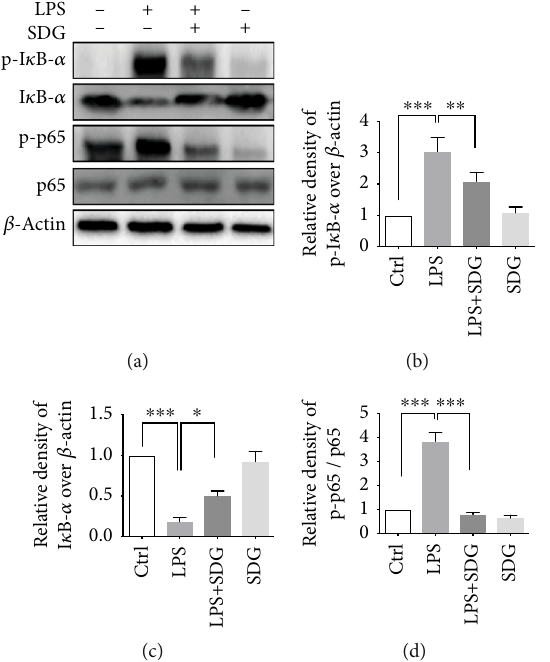
Figure 5: E ff ect of SDG on the I κ B/NF- κ B pathway in LPS- induced HUVECs. (a) Representative immunoblots of p-I κ B- α , I κ B- α , NF- κ B p65, and p-NF- κ B p65 proteins in di ff erent groups. (b – d) Semiquantitative analysis of the relative levels of p-I κ B- α , I κ B- α , and p-NF- κ B p65/p65 by a densitometric analysis. Error bars represent mean ± s : d . ∗ , ∗∗ , and ∗∗∗ represent p < 0 : 05 , p < 0 : 01 , and p < 0 : 001 , respectively. All experiments were performed in triplicate. LPS: lipopolysaccharide; SDG: secoisolariciresinol diglucoside.